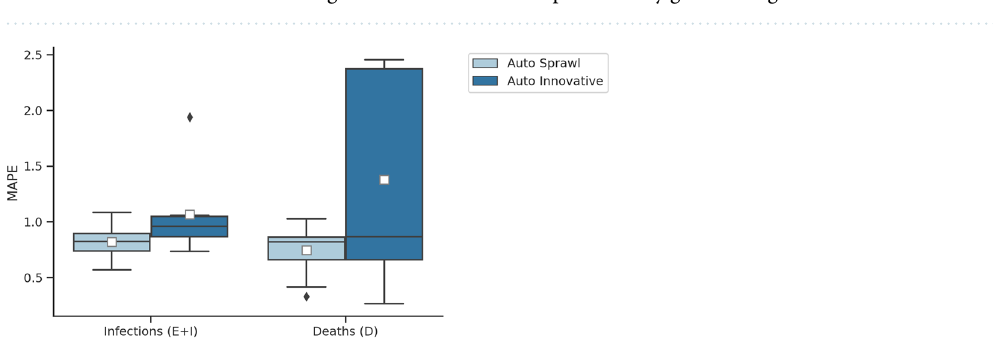
Figure 8. Infections and deaths in archetype cities. We compare simulation results to reported data on cases and mortalities. ( a ) Auto Sprawl (simulation) compared to other U.S. metropolitan areas in the same typology (e.g. Baltimore, Austin, Indianapolis). ( b ) Auto Innovative (simulation) compared to other U.S. metropolitan areas in the same typology (e.g. Boston, Chicago, San Francisco). Validation start dates were matched with earliest record of the first death. Data were obtained from the New York Times repository 60 and the JHU CSSE COVID-19 Data repository 61 summarizing the policy decisions. The restrictions put in place are represented by the red dots and the relaxation/lifting of the restrictions are represented by green triangles.